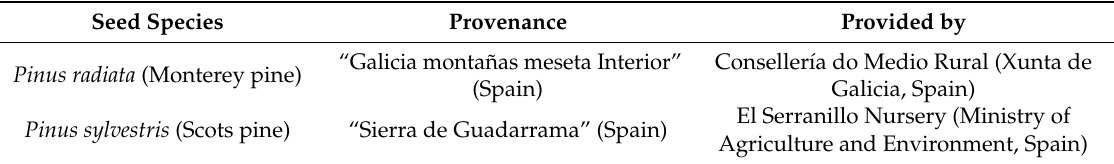
Table 1. Provenance of plan